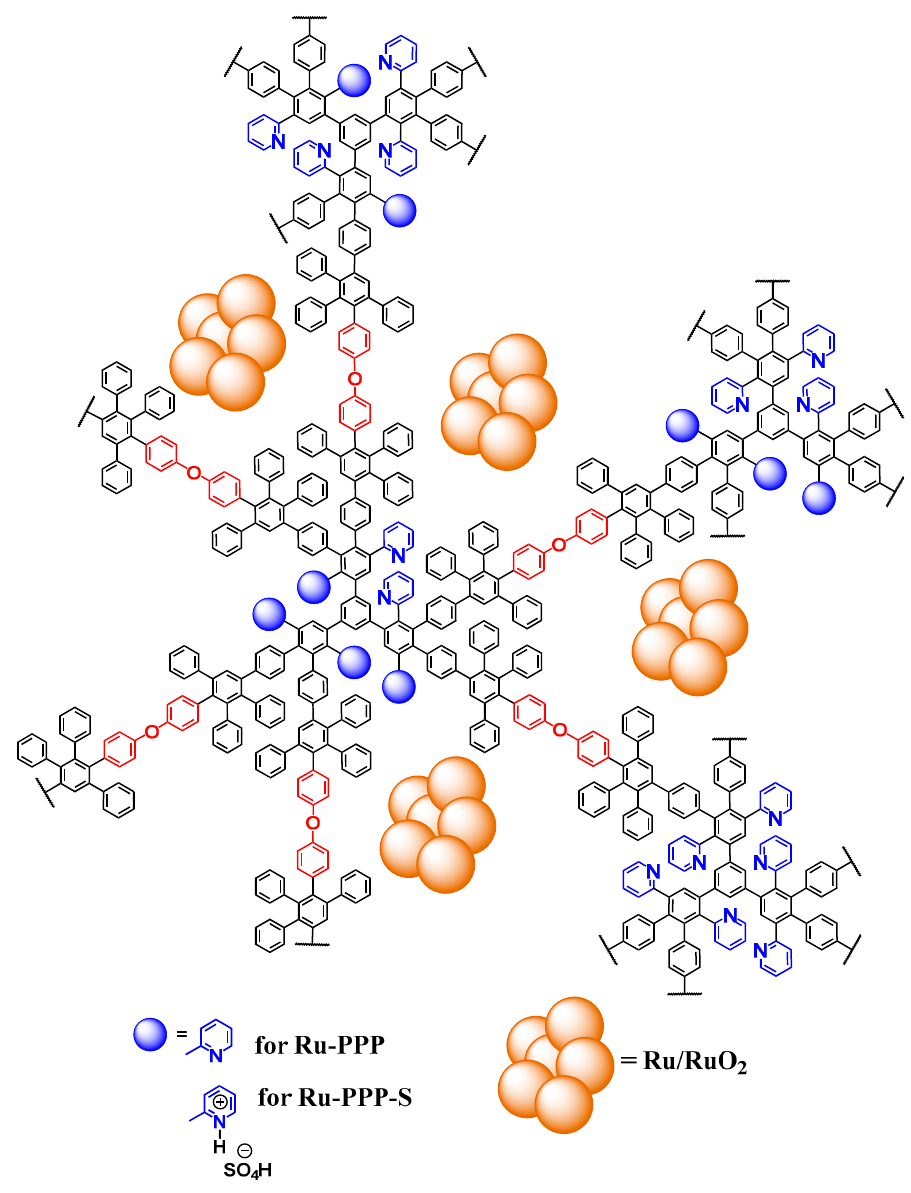
Figure 1. Schematic representation of Ru-containing catalysts based on PPP.